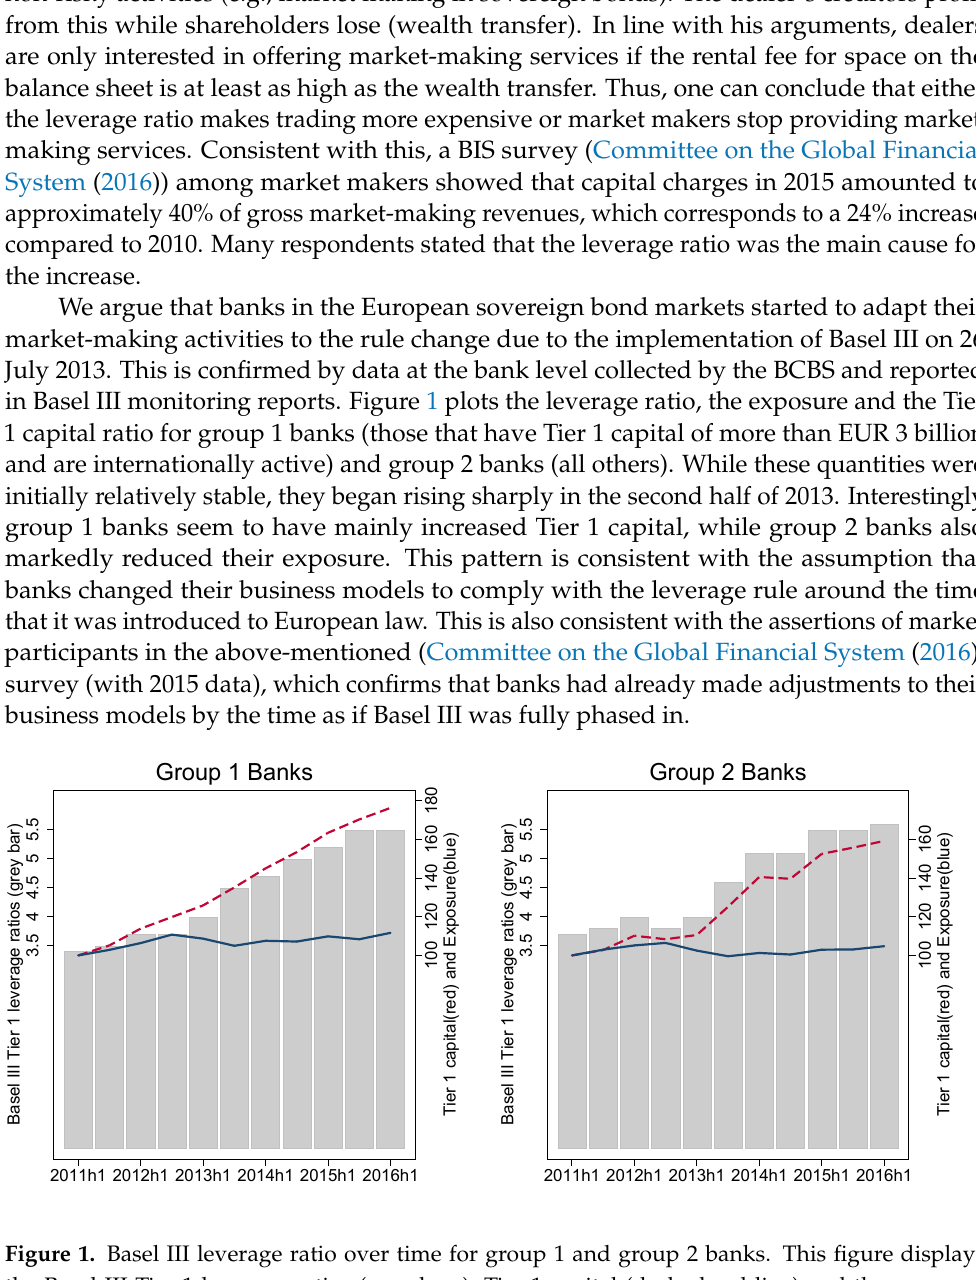
Figure 1. Basel III leverage ratio over time for group 1 and group 2 banks. This figure displays the Basel III Tier 1 leverage ratios (gray bars), Tier 1 capital (dashed red line) and the exposure measure. The Basel III leverage ratio is calculated by dividing Tier 1 capital by the exposure. The Tier 1 ratio and the exposure are calculated from accounting data and refinements, as defined in BCBS (2014). The figure shows these numbers for group 1 (banks that have Tier 1 capital of more than EUR 3 billion and are internationally active (BCBS (2017a))) and group 2 banks (all other banks) at a biannual frequency during the period from 2011 to 2016. The data are sourced from Table A.16 (p. 50) in BCBS